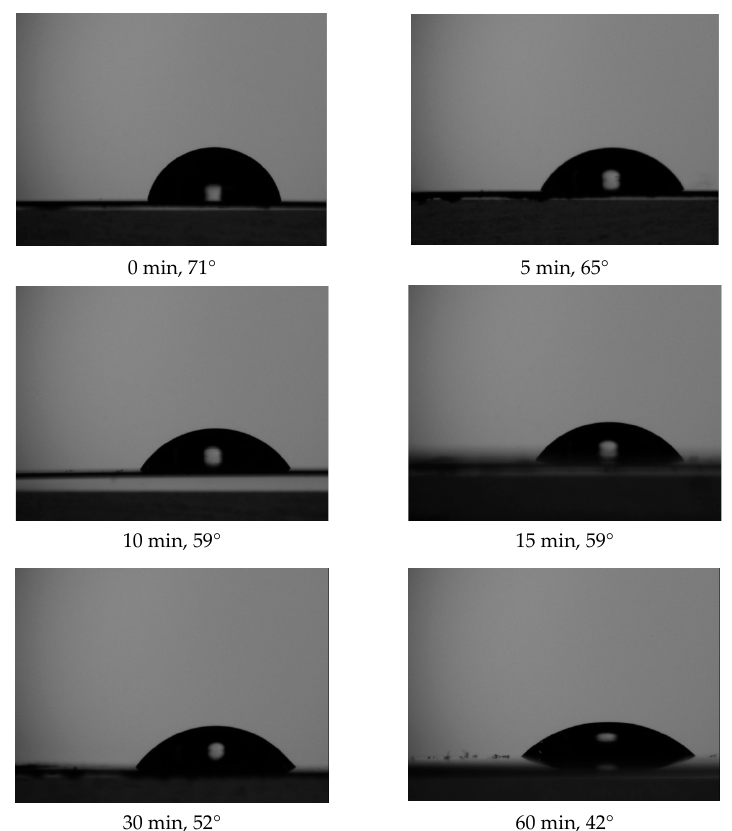
Figure 2. Water contact angle measurements in degrees after PES was treated with VUV photo- oxidation for 0, 5, 10, 15, 30, and 60 min.